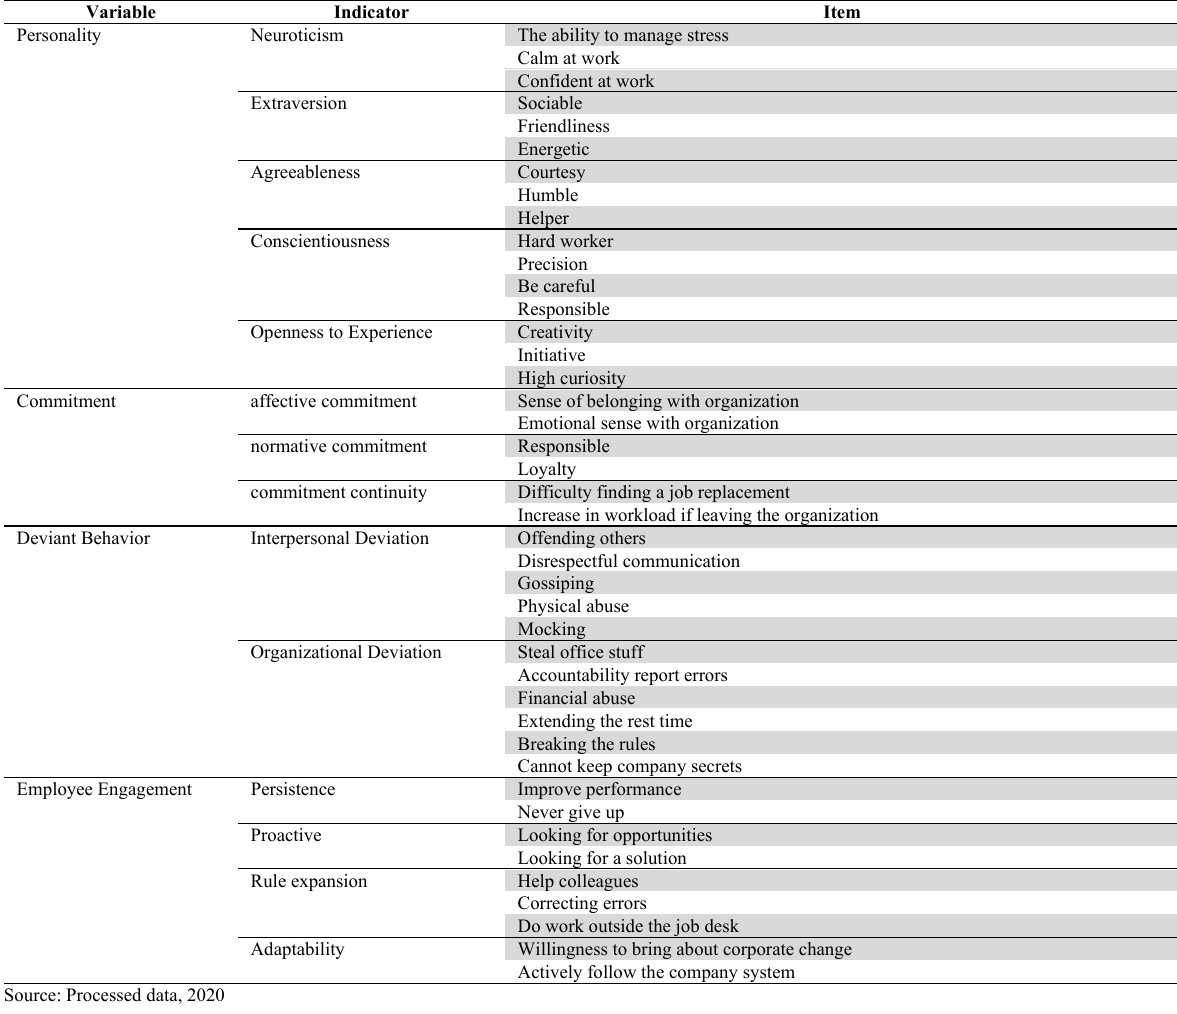
Variable Measurement